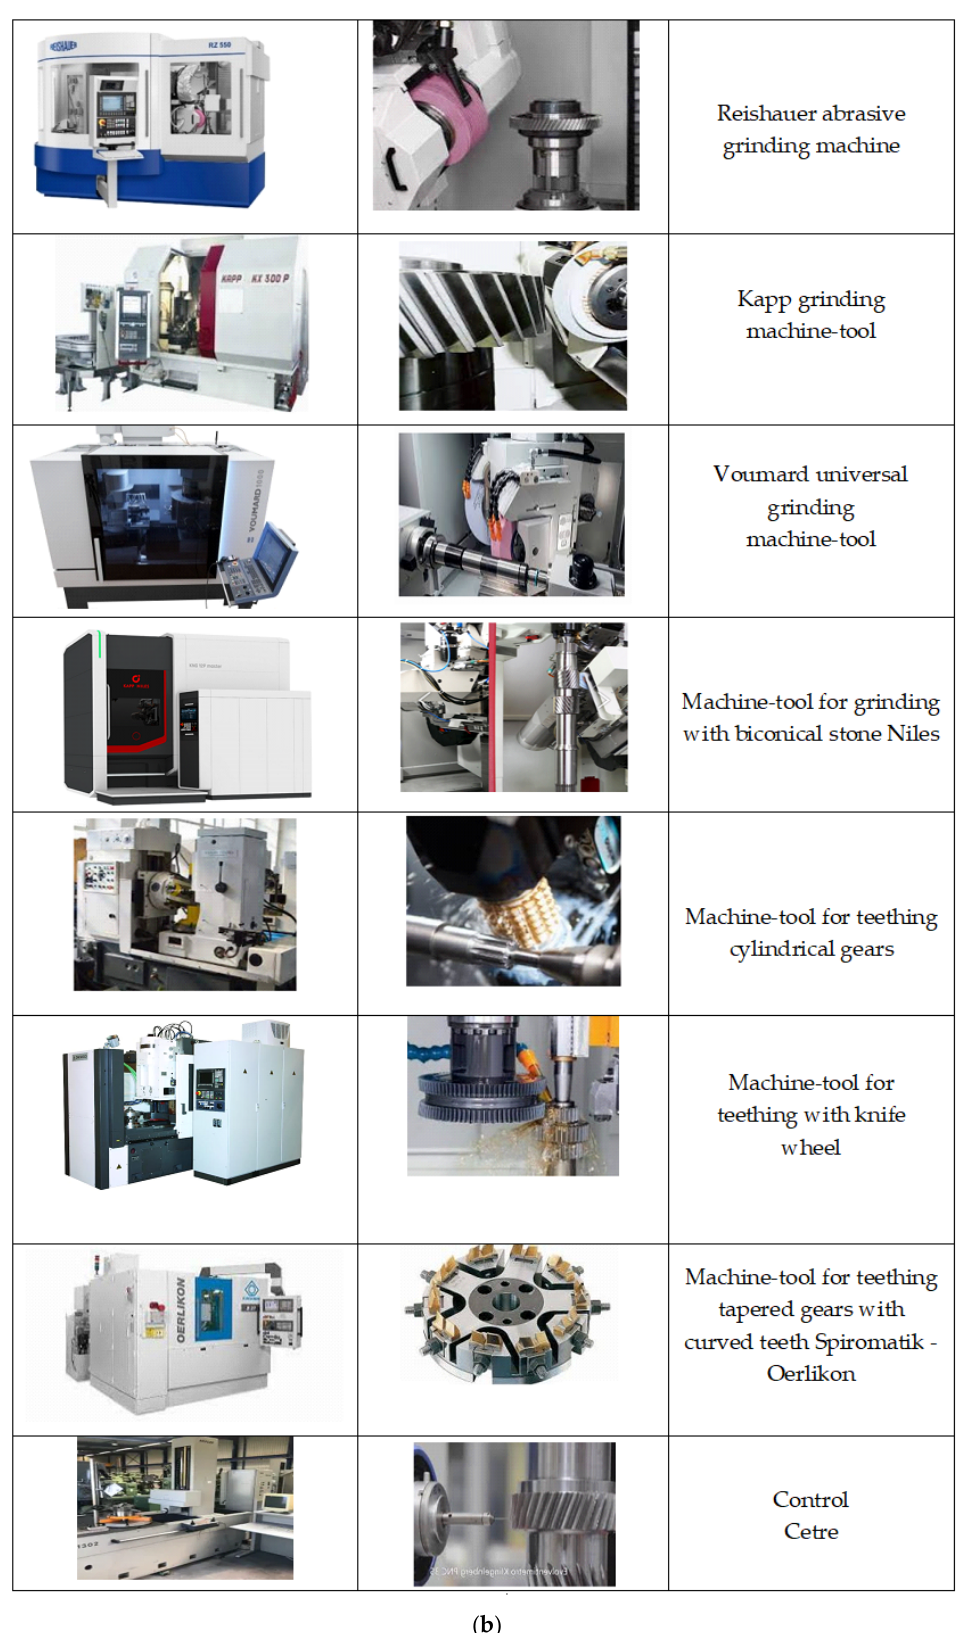
Figure 3. ( a ) Real factory case, which is small series manufactured at a real factory. ( b ) Reference machines of each category from the analyzed production department.